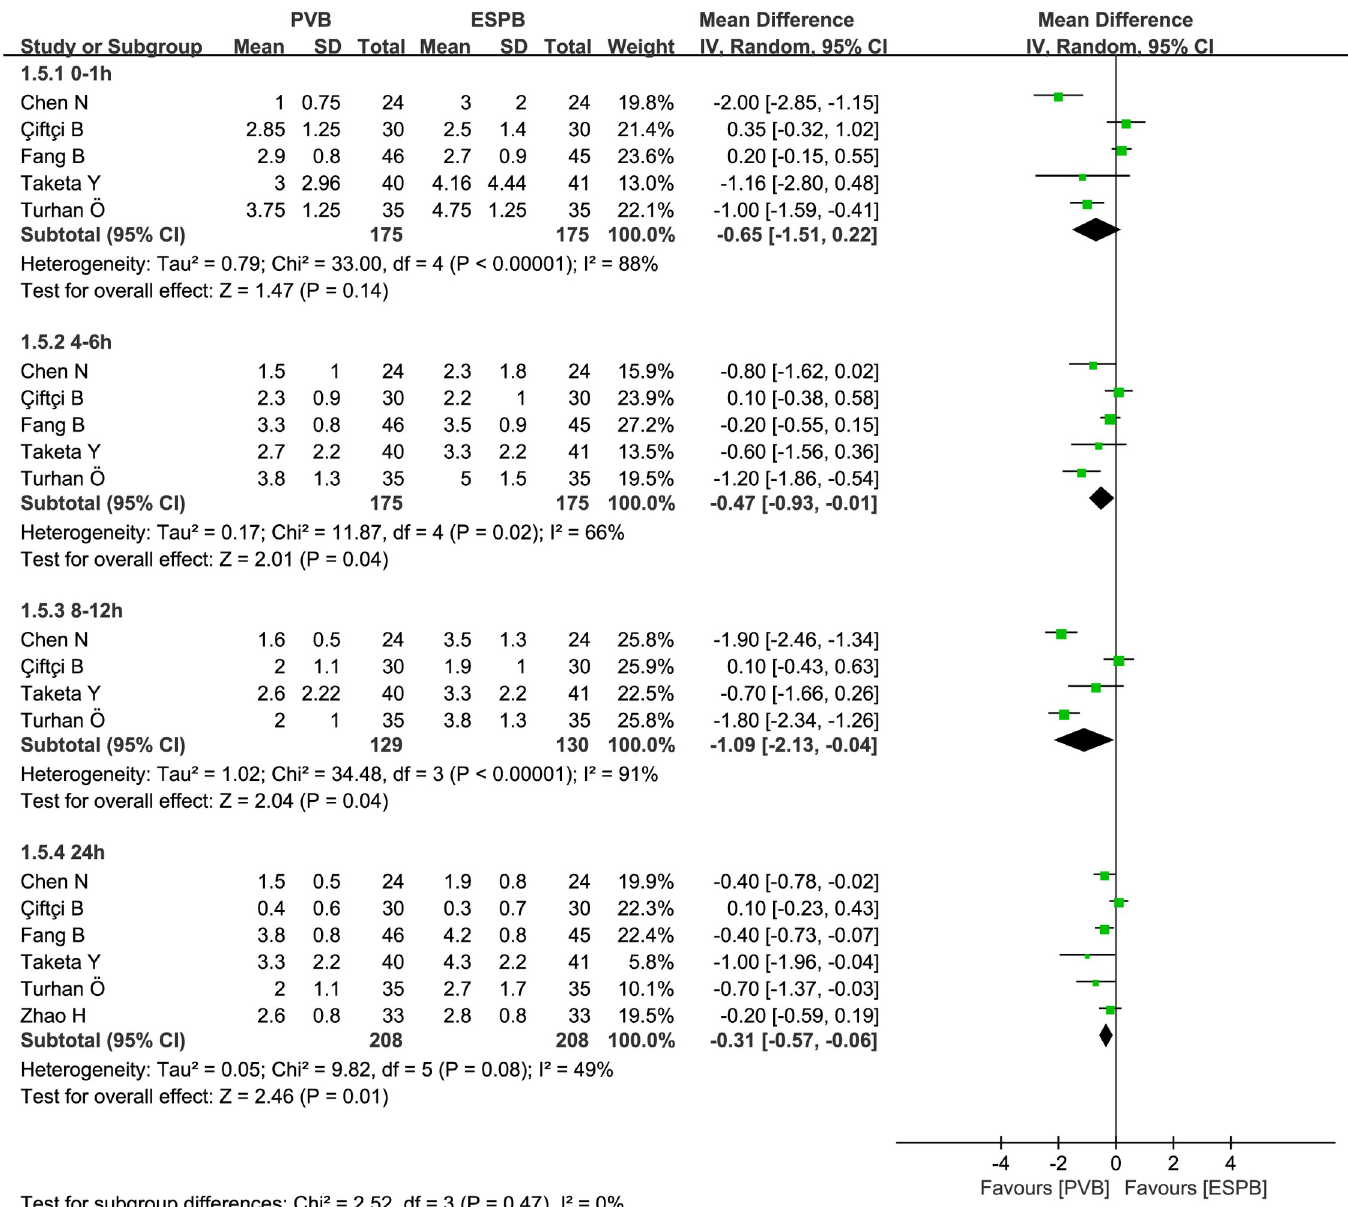
Fig 4. Forest plot of postoperative scores for moving pain at 0–1, 4–6, 8–12, and 24 hours.